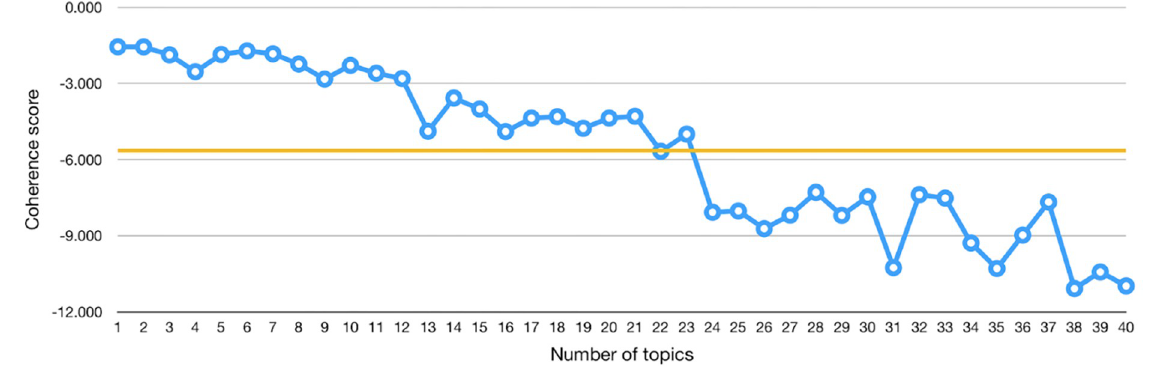
Fig 8. A plot example of the coherence score of different LDA topic models built using a variable number of topics, from 1 to 40. The orange line is the average value, and it plateaus around 22–23 topics.